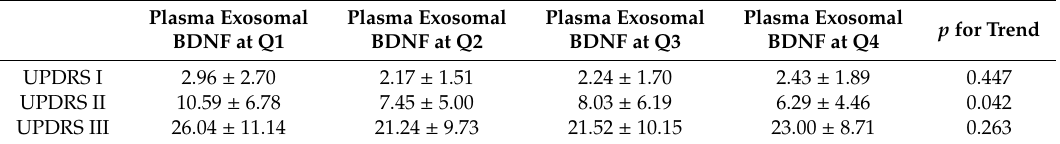
Table 2. Unified Parkinson’s Disease Rating Scale (UPDRS) scores of patients with PD categorized into four groups based on the quartile (Q1 to Q4, low to high) for the plasma exosomal brain-derived neurotrophic factors (BDNF) level.